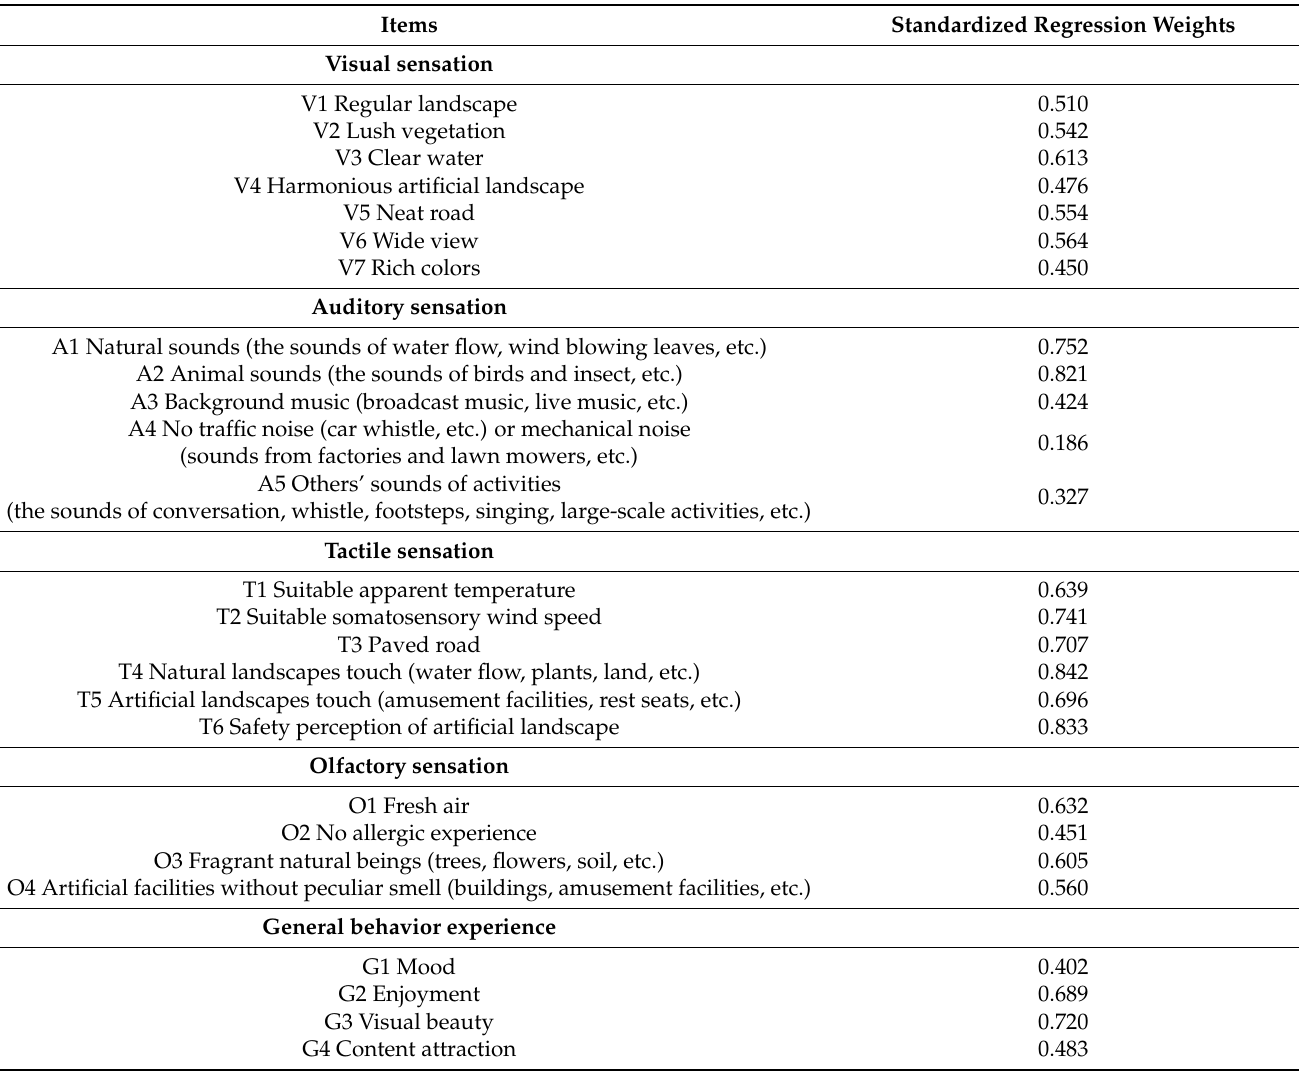
Table 4. Structural equation model standardized regression weights of observed variables.